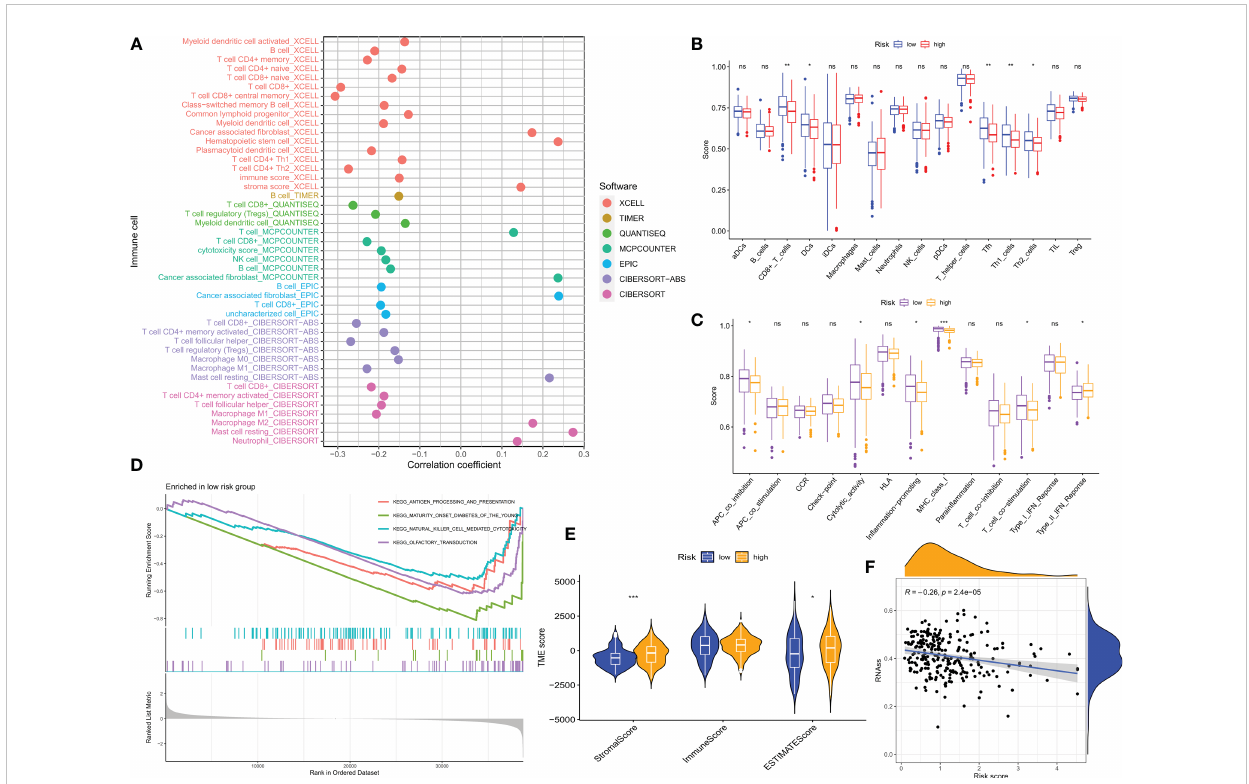
FIGURE 8 CM risk score predicts TME and immune cell in fi ltration. (A) Bubble plots obtained by different algorithms show the correlation between risk scores and immune cell content. (B) Differences in immune cell in fi ltration between populations in different risk groups. (C) Differences in immune function between populations in different risk groups. (D) CMRGPS-based enrichment analysis of KEGG gene sets in low-risk populations. (E) Differences in TME scores between populations in different risk groups. (F) Correlation of cancer stem cell index (RNAss) with risk scores. *p < 0.05, **p < 0.01, ***p < 0.001; ns, no signi fi